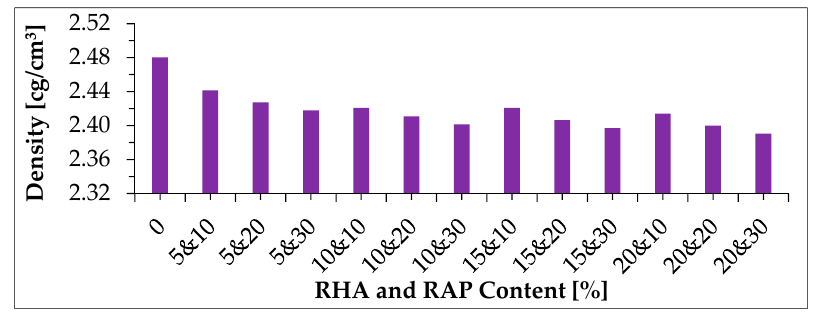
Figure 7. Fresh density for both RHA- and RAP-inclusive concrete.